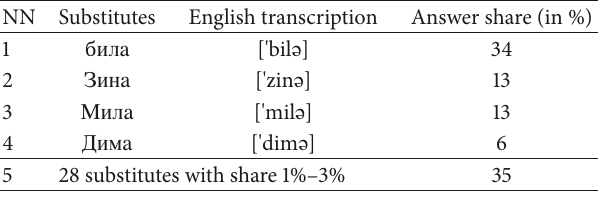
Table 5: Main substitutes (4% and more) for phonogram « 3KS1 » (['bil J ], Eng.: « beat »): native German speakers at signal-to-noise ratios = − 9 and − 12 dB ([Base: 𝑛 = 107 ]).